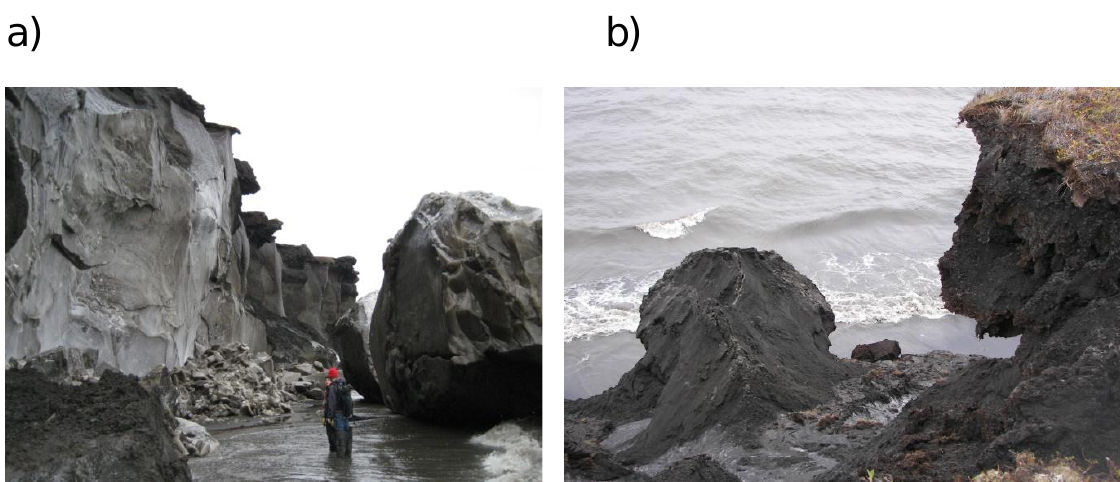
Fig. 2. Coastal erosion as seen on the northern cape of Muostakh Island (photos by I. P. Semiletov). During < 2weeks in early September 2006, the northern cape of Muostakh Island (Buor-Khaya Bay of the Laptev Sea) retreated > 20m, delivering a large amount of eroded organic matter to the sea: (a) and (b) represent different parts of the